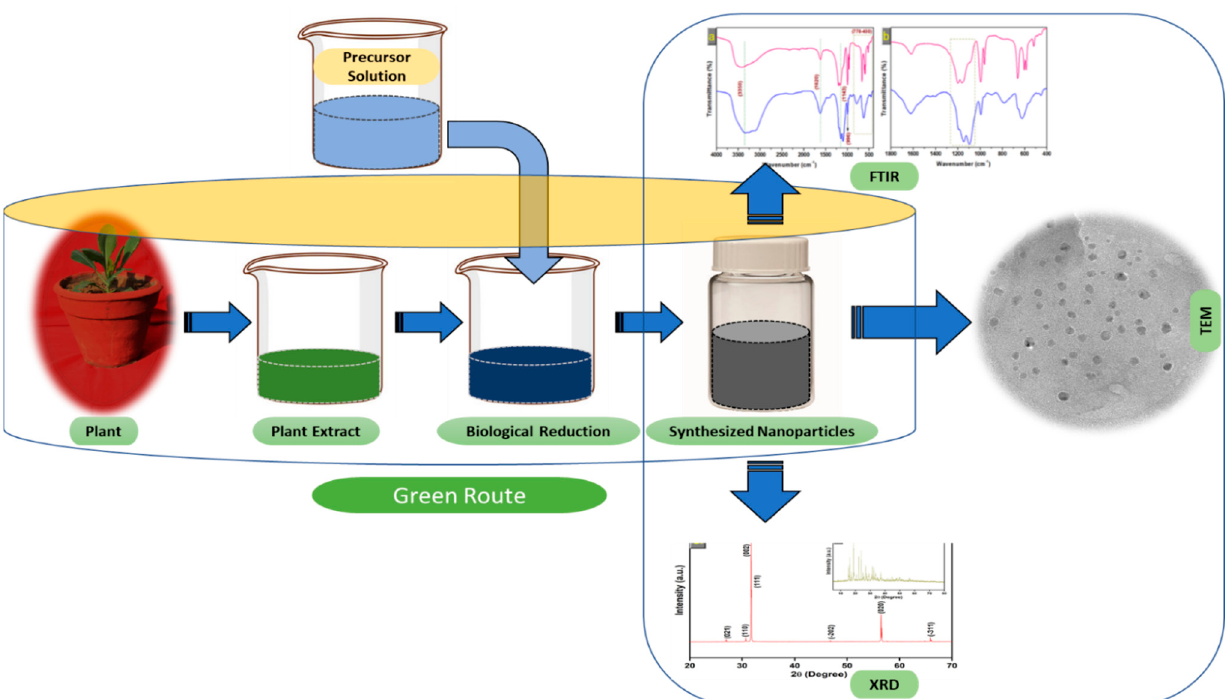
Figure 3. The schematic diagram for the biosynthesis of nanoparticles (NPs) via a green route using plant extract.